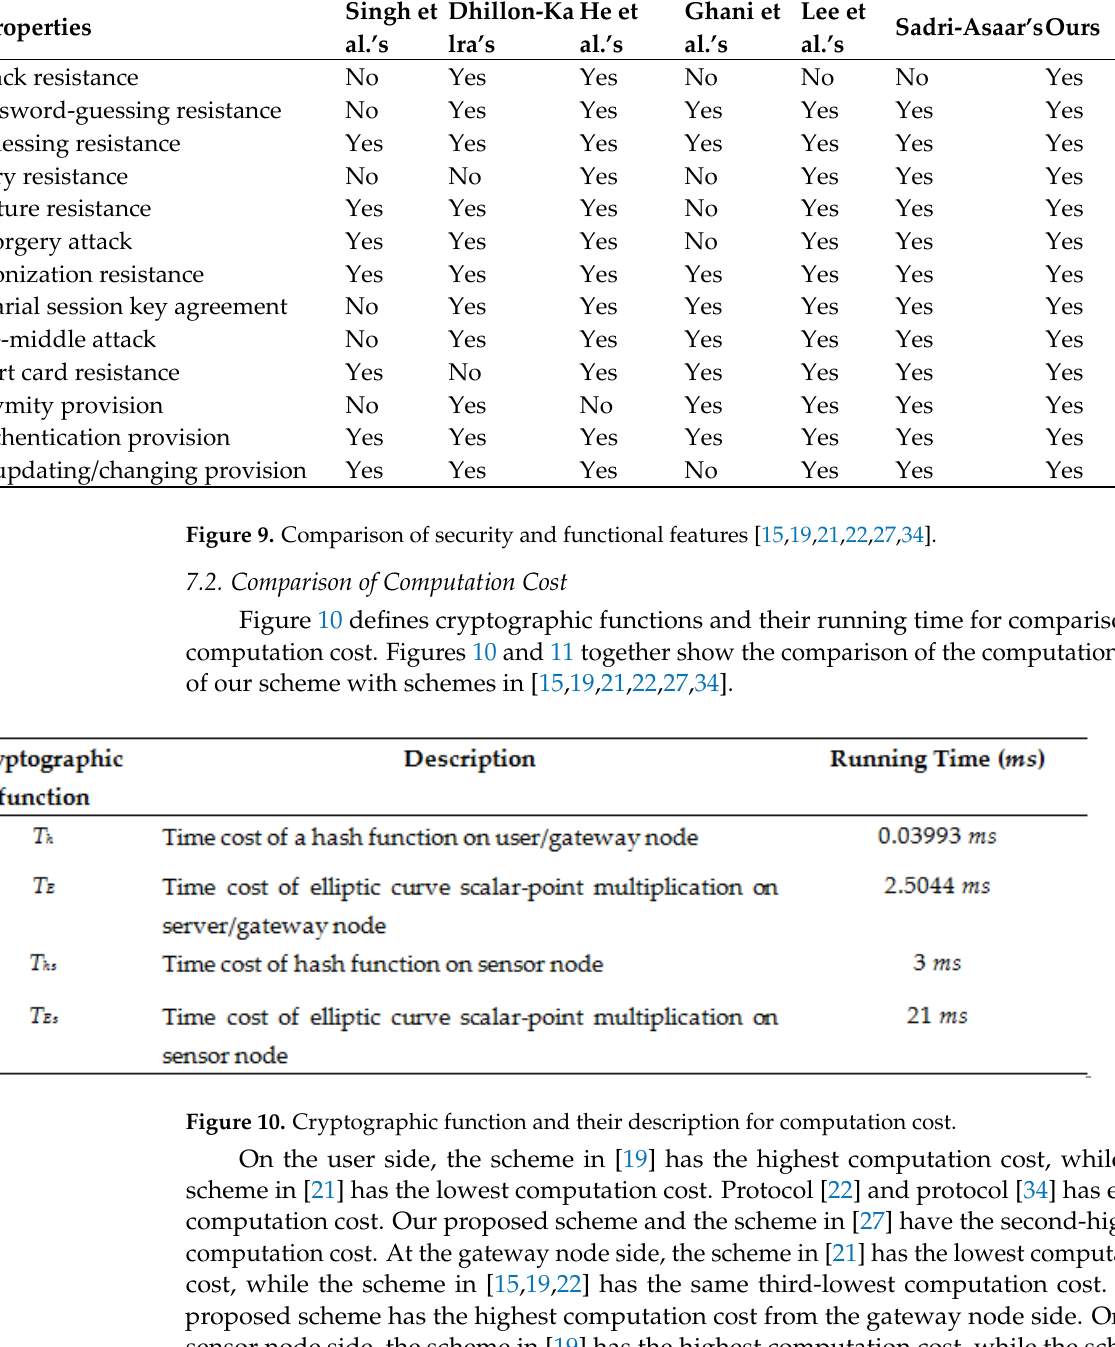
Figure 11. Comparison of computation cost . Figure 12. Comparison of computation cost. Our proposed scheme can be a little bit more costly than other related schemes, but our scheme has passed various hurdles in security checks which makes it user-friendly.